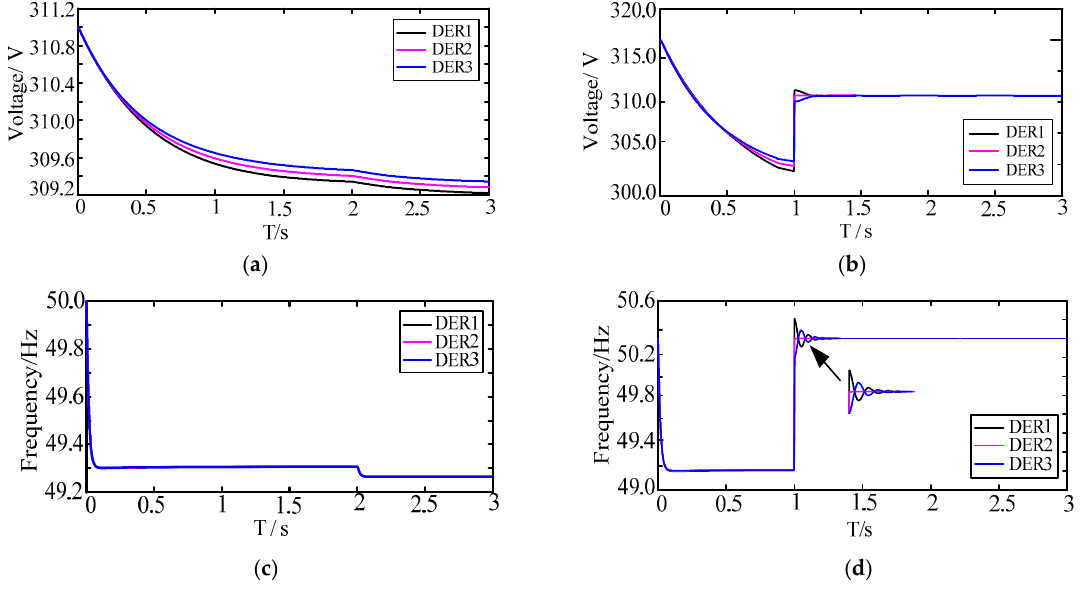
Figure 6. Variations of DERs when Load2 is added at t = 2 s. ( a ) Variations of voltage by using traditional droop control; ( b ) Variations of voltage by using the novel distributed control; ( c ) Variations of frequency by using traditional droop control; ( d ) Variations of frequency by using the novel distributed control.